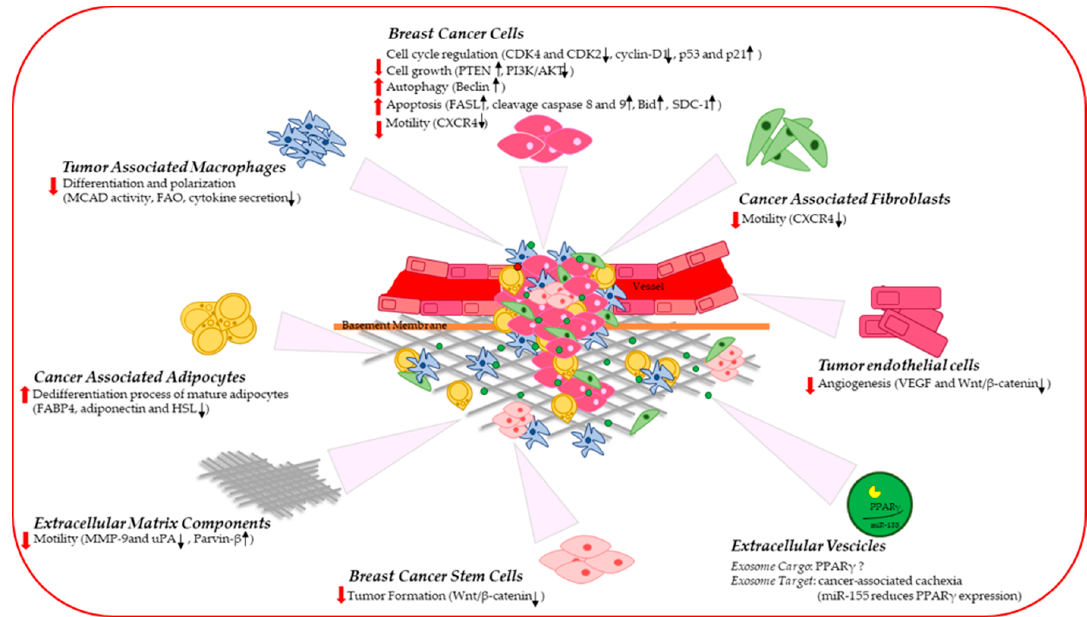
Figure 1. A schematic illustration showing the potential tumor suppressor role exerted by PPAR γ in the breast cancer microenvironment. CDK: cyclin-dependent kinase; PTEN: phosphatase and tensin homolog on chromosome ten; PI3K/AKT: phosphatidylinositol 3-kinase/protein kinase B; FASL: FAS Ligand; SDC-1: syndecan-1; CXCR4: C-X-C chemokine receptor type 4; MCAD: medium-chain acyl-CoA dehydrogenase; FAO: fatty acid oxidation; FABP4: fatty acid binding protein 4; HSL: hormone-sensitive lipase; VEGF: vascular endothelial growth factor; MMP9: Matrix metallopeptidase 9; uPA: urokinase plasminogen